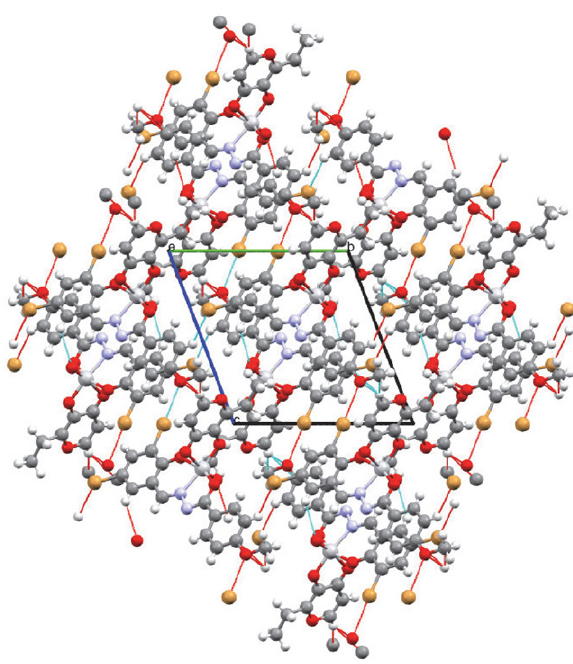
Fig. 4. Hydrogen bonds linked structures of complex 2 , viewed along the a axis. Hydrogen bonds are shown as dashed lines.